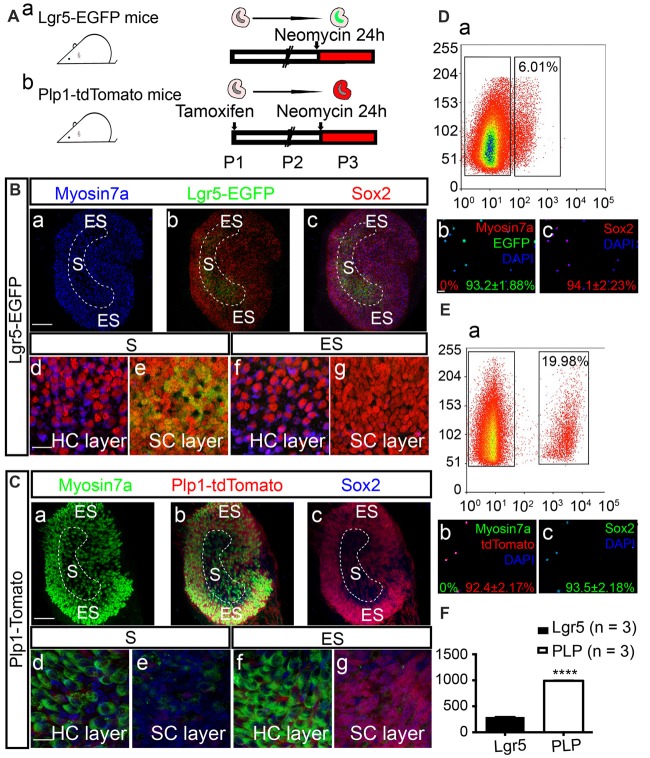
Expression patterns of Lgr5 and Plp in the utricle after neomycin damage. (A) Tamoxifen was injected into Plp1-CreERT-tdTomato mice on P1 to activate Cre recombinase. Utricles from both Lgr5-EGFP-CreERT mice (Aa) and Plp1-CreERT-tdTomato mice (Ab) were isolated for culture on P2. The utricles were cultured with neomycin for 24 h and then collected for analysis on P3. (B,C) Images showing the Lgr5-EGFP and Plp1-tdTomato expression patterns in utricles. High-magnification images show the hair cell (HC) nuclear layer and supporting cell (SC) nuclear layer of both the striolar region (S) and extrastriolar region (ES; Bd–g,Cd–g). After 24 h of neomycin exposure, HC death was observed primarily in the striolar region (Ba,Ca). Neomycin-induced HC damage activated SCs to re-express Lgr5-EGFP in the same region (Bb,c,Be), and tdTomato mainly labeled SCs in the extrastriolar region in Plp-CreERT-tdTomato mice (Cbc,Cg). (D,E) Lgr5-EGFP+ SCs and Plp1-tdTomato+ SCs were isolated by fluorescence activated cell sorting (FACS). The percentage of Lgr5-EGFP+ cells was 6.02% (Da), and the percentage of Plp1-tdTomato+ cells was 19.98% (Ea). Immunostaining confirmed that purified Lgr5+ cells robustly expressed EGFP (93.2% ± 1.88%) and Sox2 (94.1% ± 2.33%), but not the HC marker Myosin7a (0.0%; Db,c). Of the isolated Plp1+ cells, 92.4% ± 1.2% were tdTomato+, 93.5% ± 2.18% were Sox2+, and none were Myosin7a+ (Eb,c). (F) The numbers for Lgr5-EGFP+ and Plp1-tdTomato+ cells per utricle. Data are shown as the mean ± SD; t-test, ****p < 0.001, n = 3. Scale bars are 100 μm in (Ba–c) and (Ca–c) and 20 μm in (Bd–g,Cd–g,Db,c,Eb,c).